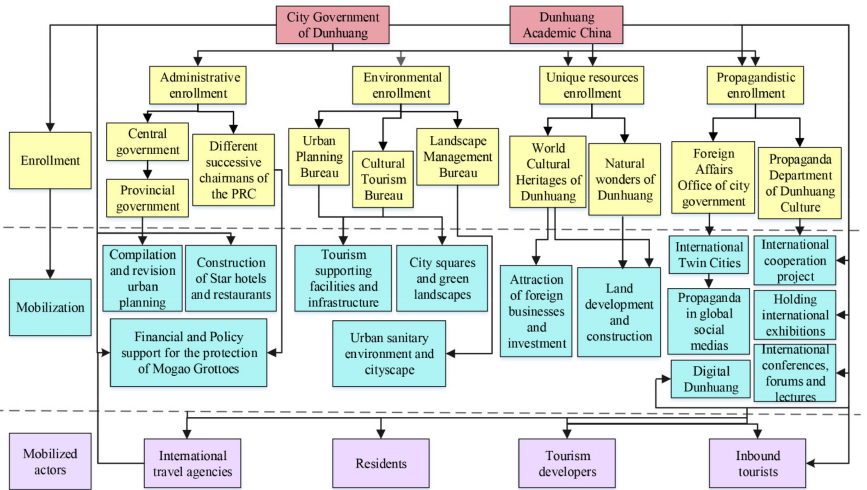
Figure 8. The formation of multiple cooperation network in the phase of world cultural heritage destination